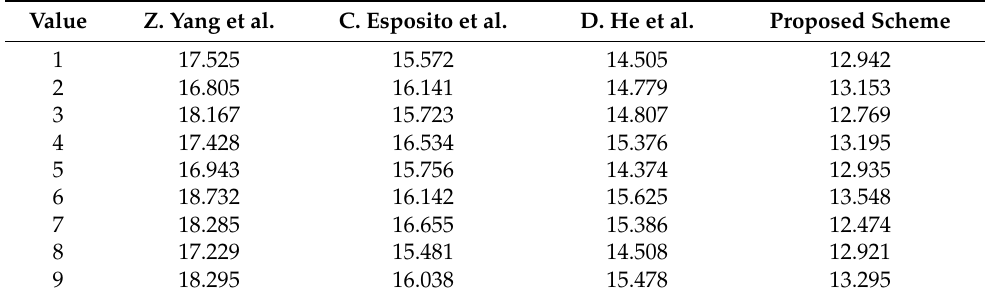
Table 3. IoT integrity verification time by blockchain generation probability value. Units: